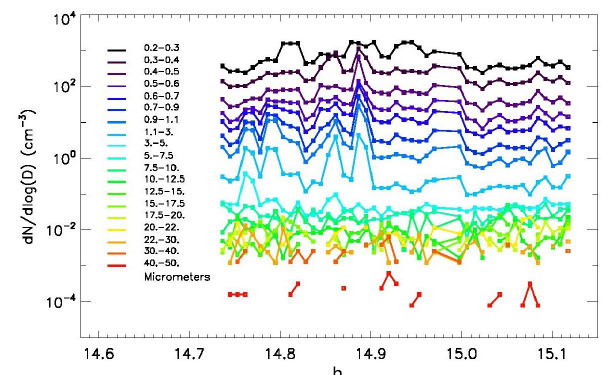
Figure 3. Aerosol particle size distribution from LOAC flight on- board an unmanned aerial vehicle flown close to the surface in peri- urban conditions near Bordeaux–Mérignac (France) on 18 Decem- ber 2013 at 14:30UT; the uncertainty (at 1 σ ) is of about ± 20% for concentrations higher than 10 − 1 cm − 3 up to ± 60% for concentra- tions lower than 10 − 2 cm − 3